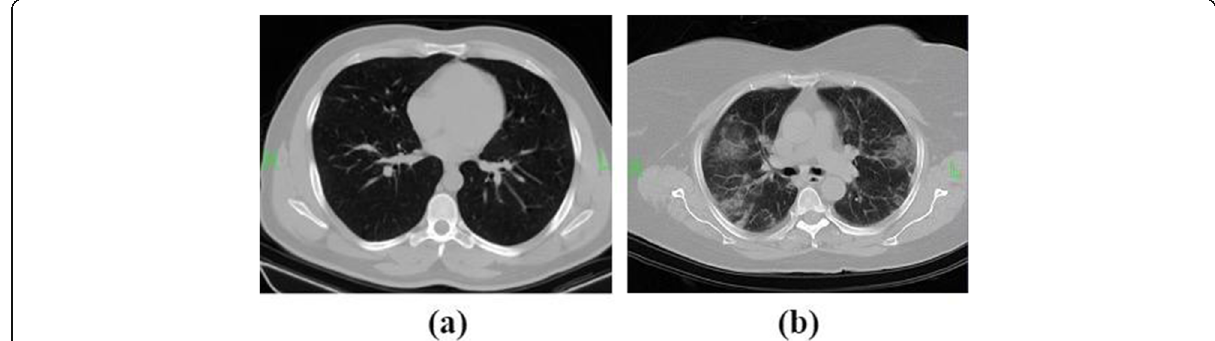
Fig. 1 Sample of CT images from patients with suspected COVID-19 ( a ) and confirmed ( b